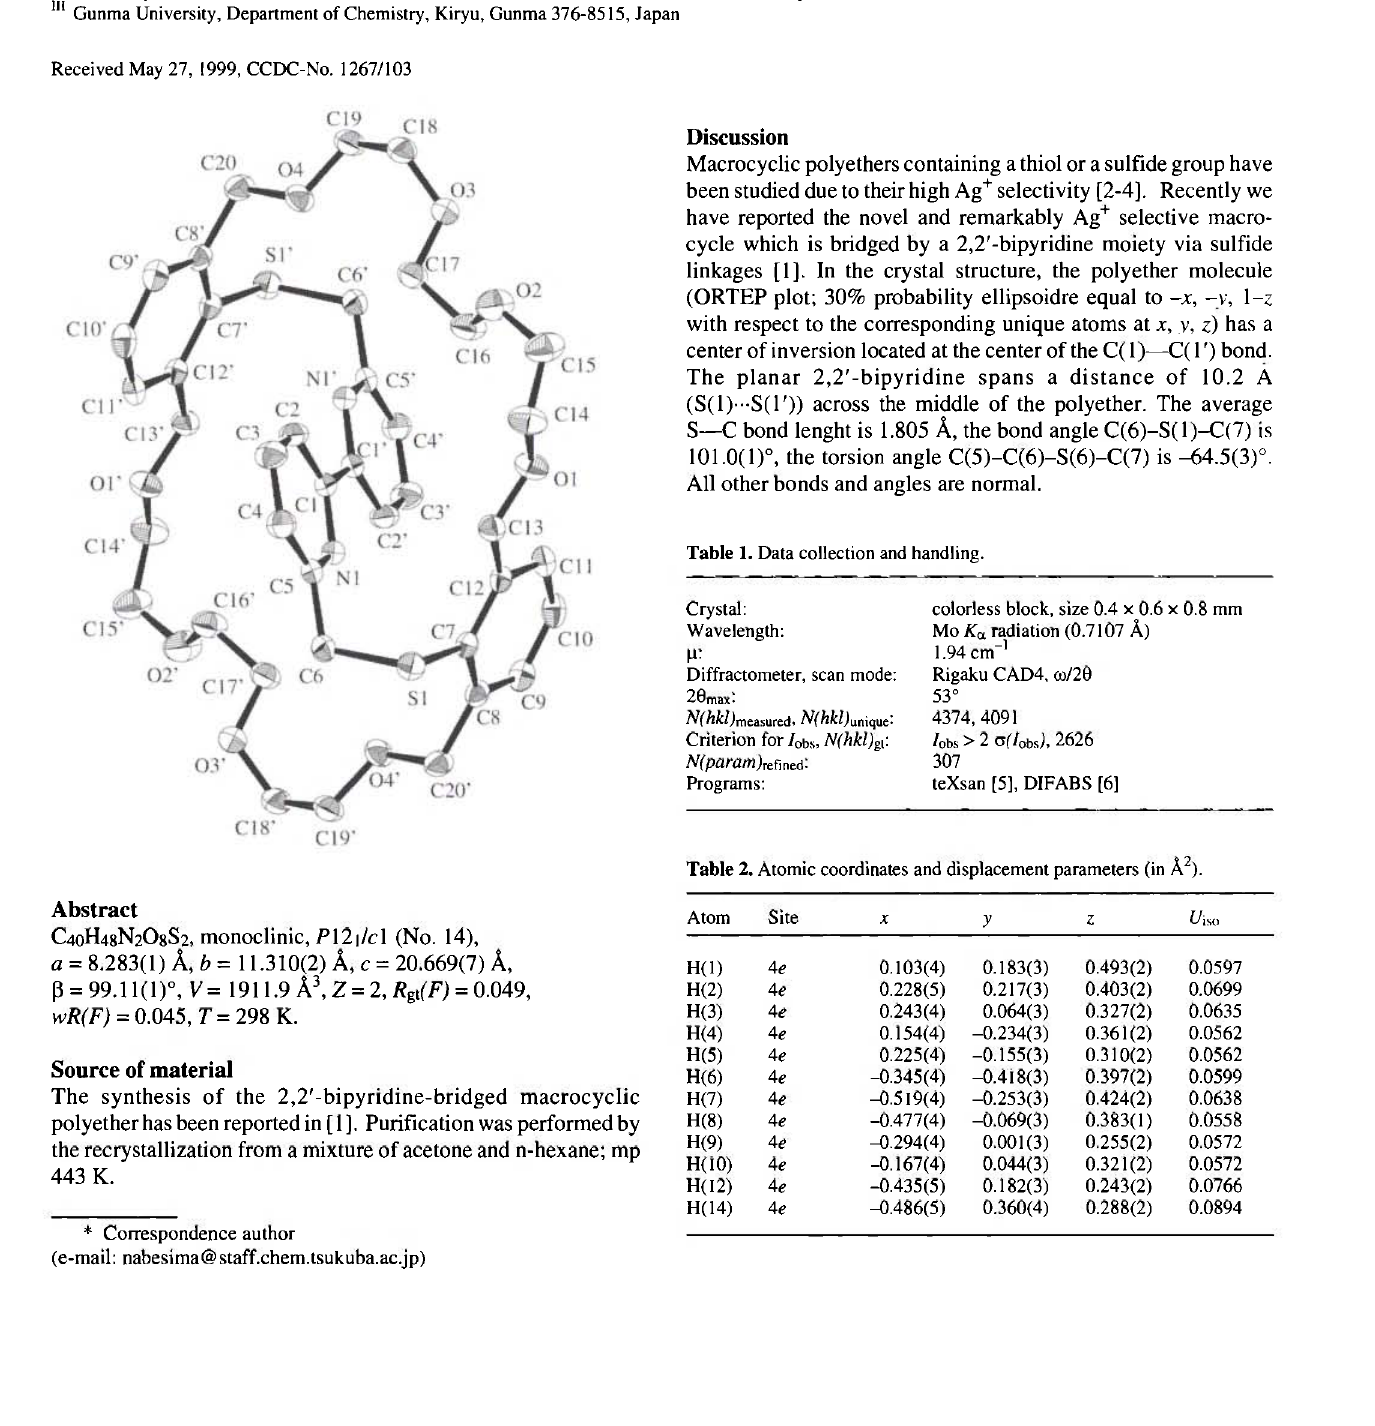
Table 2. Atomic coordinates and displacement parameters (in A 2